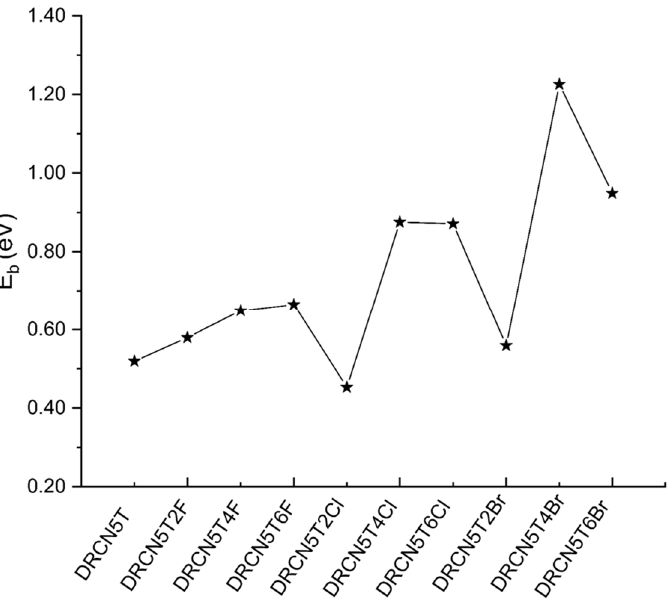
Figure 7. The calculated exciton binding energy of DRCN5T, DRCN5T2F, DRCN5T4F, DRCN5T6F, DRCN5T2Cl, DRCN5T4Cl, DRCN5T6Cl, DRCN5T2Br, DRCN5T4Br, and DRCN5T6Br with CAM- DRCN5T2Cl, DRCN5T4Cl, DRCN5T6Cl, DRCN5T2Br, DRCN5T4Br, and DRCN5T6Br with CAM- B3LYP/6 − 31+G(d) in film ( ε = B3LYP/6 − 31+G(d) in film ( ε = 3.0 ).